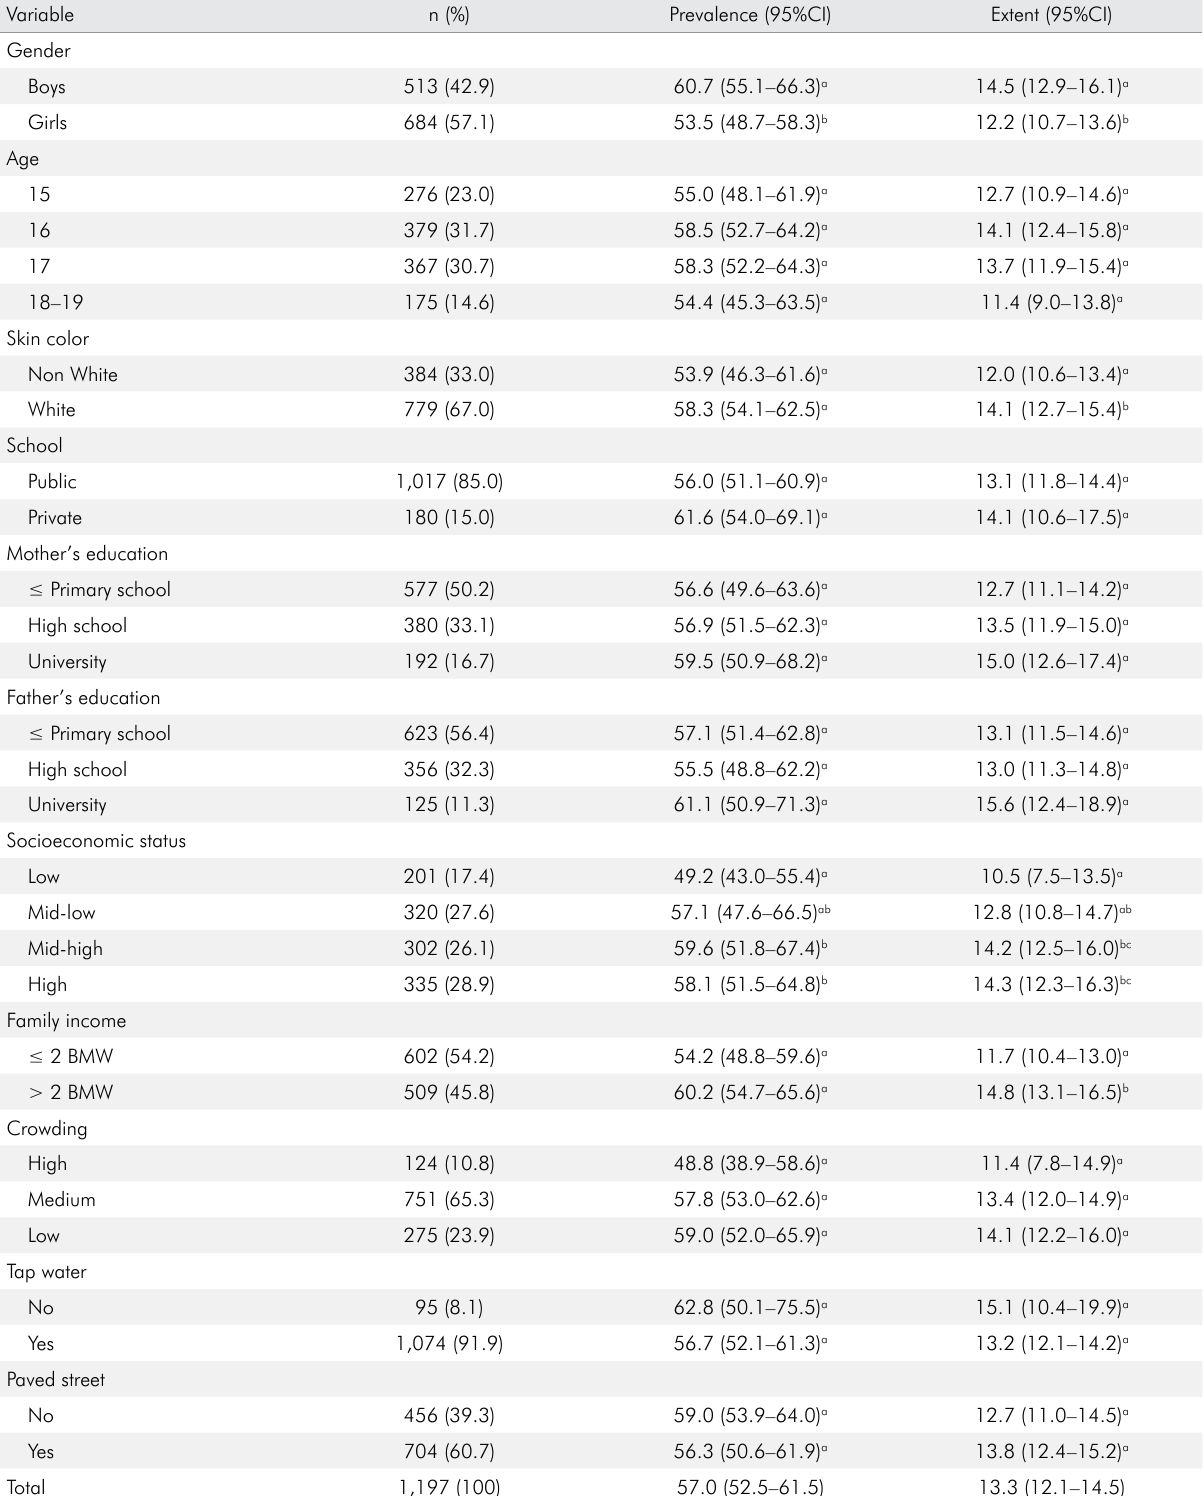
Table 1. Sample distribution, prevalence and extent (mean number of affected surfaces) of ETW by explanatory variables. Santa Maria, Brazil, 2018 (n =